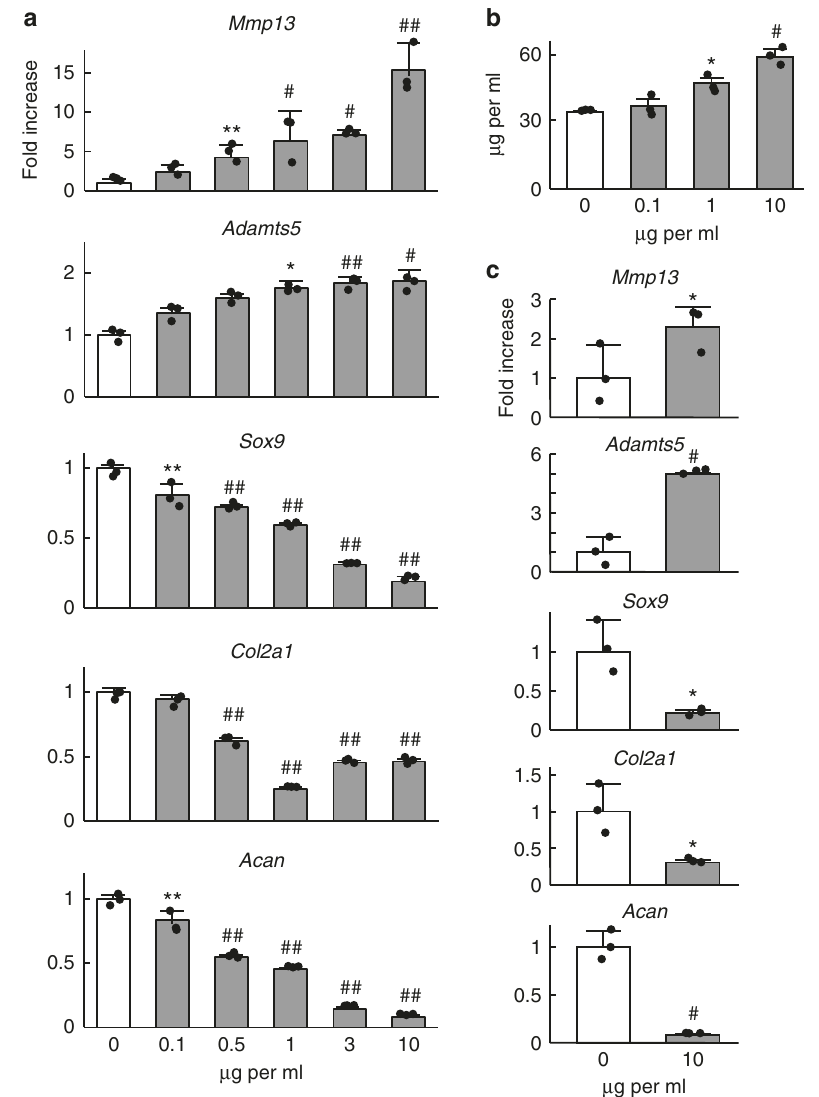
Fig. 2 Catabolic effects of gremlin-1 in cultured chondrocytes. a mRNA levels of marker genes in primary mouse articular chondrocytes treated with recombinant human gremlin-1 (rhGREM1) for 24 h. b Amount of glycosaminoglycans (GAG) released into the culture medium determined by dimethylmethylene blue assay of wild-type mouse femoral heads cultured with various amounts of rhGREM1 for 3 days. c mRNA levels of marker genes in mouse femoral heads cultured with 10 µ g/mL rhGREM1 for 3 days. All data are expressed as mean ± SD of biologically independent three samples per group. * P < 0.05, ** P < 0.01, # P < 0.005, ## P < 0.001 versus 0 (vehicle) (one-way ANOVA